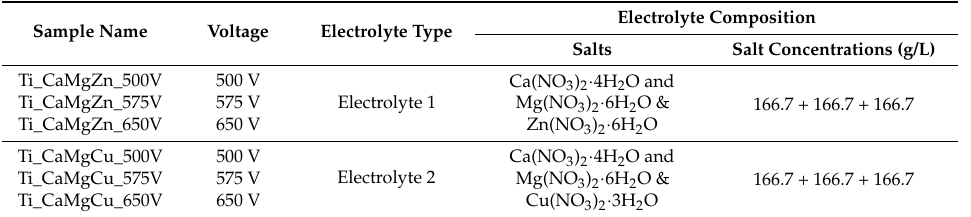
Table 2. Experimental plan and code sample